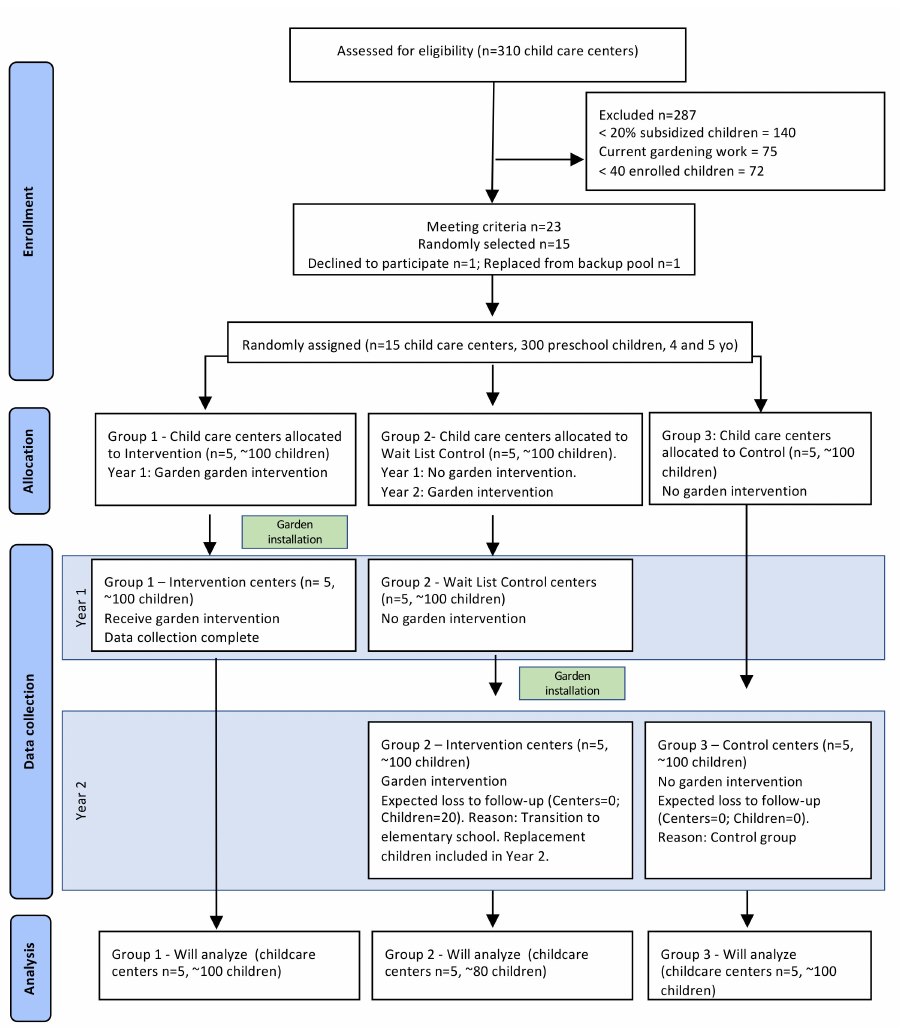
Figure 7. COLEAFS CONSORT